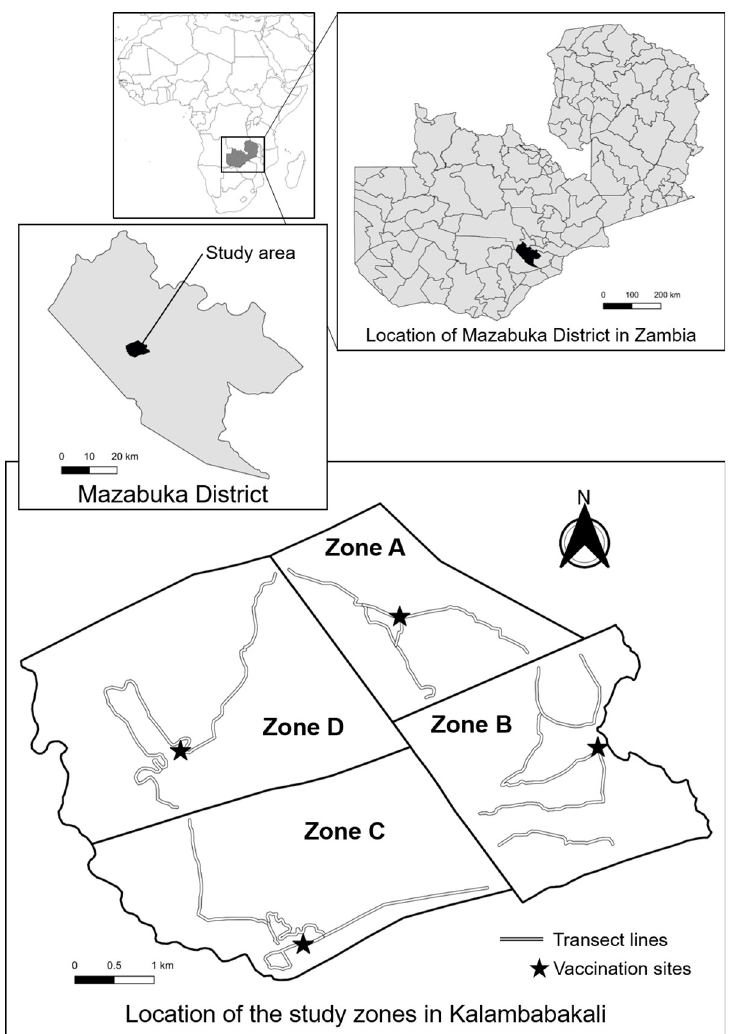
Fig 1. Location of the study area in Kalambabakali, Mazabuka District of Zambia. Study area consists of four continuous zones (Zone A, B, C and D) in Kalambabakali. Map of the African Continent was obtained from the Natural Earth (https://www.naturalearthdata.com/). Map of Zambia was downloaded from the Humanitarian Data Exchange (https://data.humdata.org/dataset/zambia-administrative-boundaries-level-1-provinces-and-level- 2-districts-with-census-2010-population), which is shared under Creative Commons Attribution for Intergovernmental Organizations license (https://creativecommons.org/licenses/by/3.0/igo/legalcode). The shapefiles provided under this license themselves were not modified, but the shapefiles originally created for representing study area were overlaid on the shapefiles corresponding to Mazabuka District. Maps were created using the QGIS 3.10 software